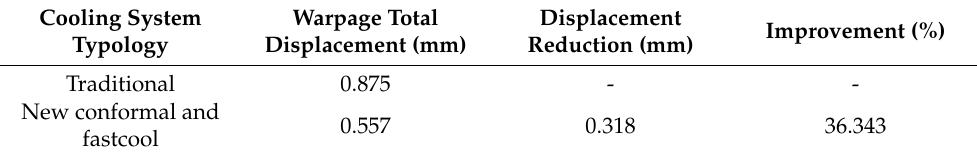
Table 10. Warpage total displacement for the analyzed cooling systems.